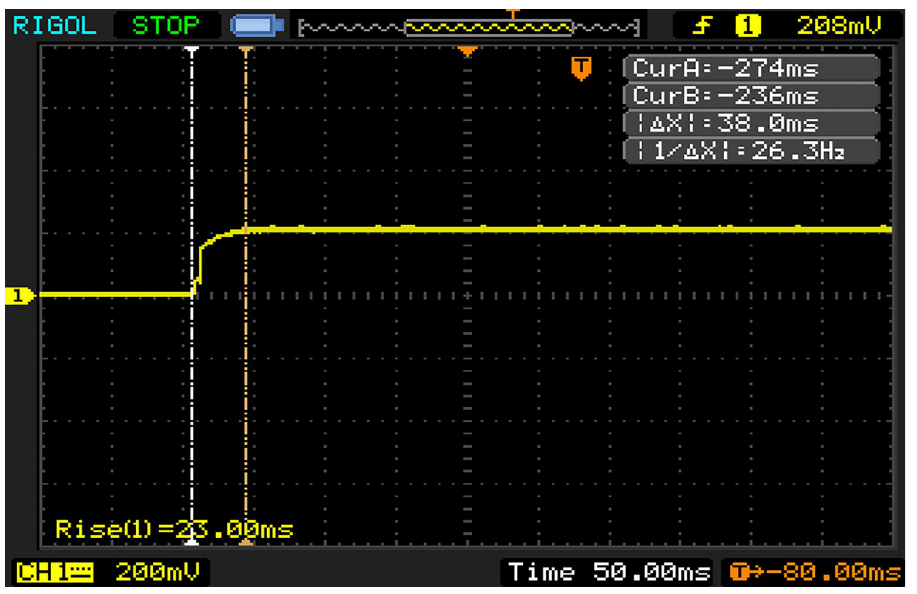
Fig 9. The dynamic response of temperature sensor.